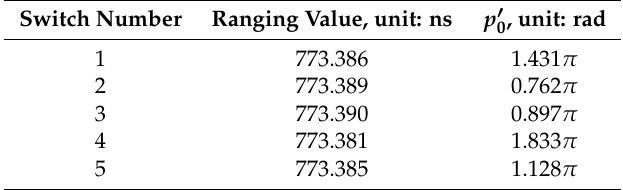
Table 3. Collected actual power switch ranging data with the phase compensation